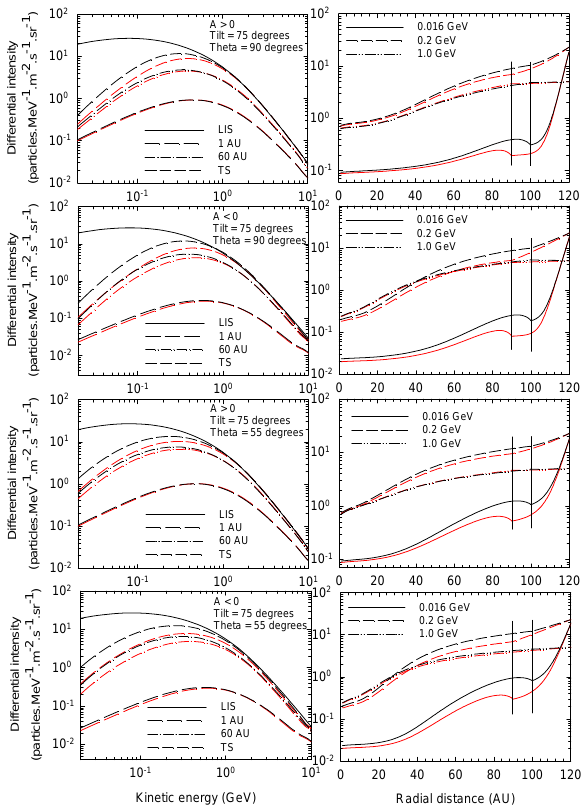
Fig. 2. Similar to Fig. 1 but with the TS positioned at 90 AU (red curves) and 100 AU (black curves), respectively, as indicated with the heliopause position specified at 120 AU.